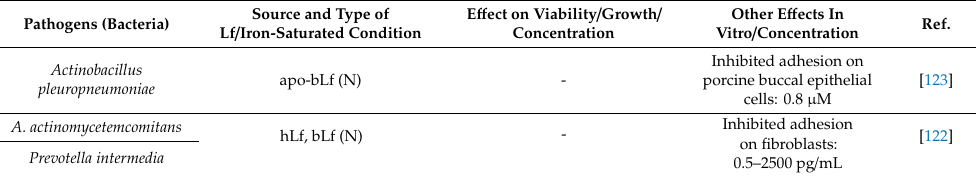
Table 1. E ff ects of lactoferrin and lactoferricins on pathogenic bacteria. Pathogens